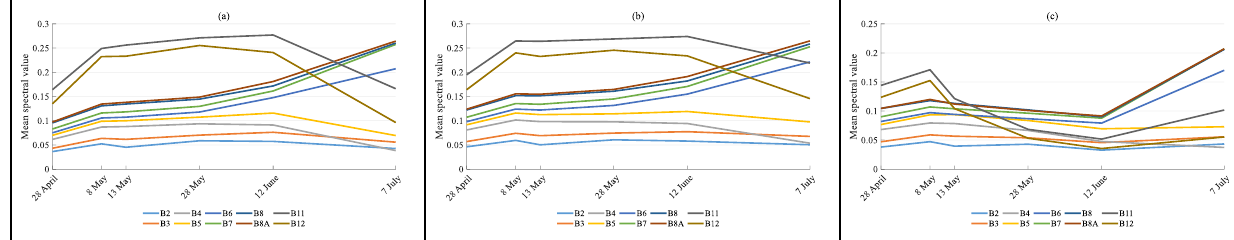
Figure 3. The mean spectral values of the three crops at different periods. ( a ) The mean spectral values of corn at different periods, ( b ) The mean spectral values of soybean at different periods, and ( c ) The mean spectral values of rice at different periods.